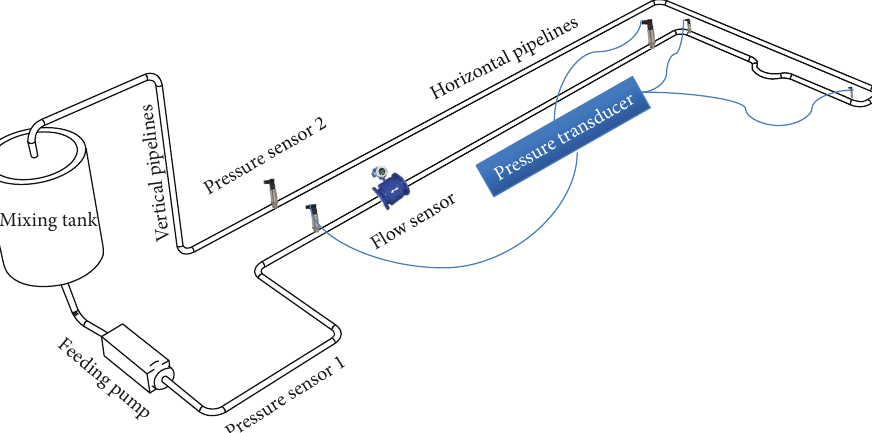
Figure 5: Sketch map of pipeline of PGBS loop